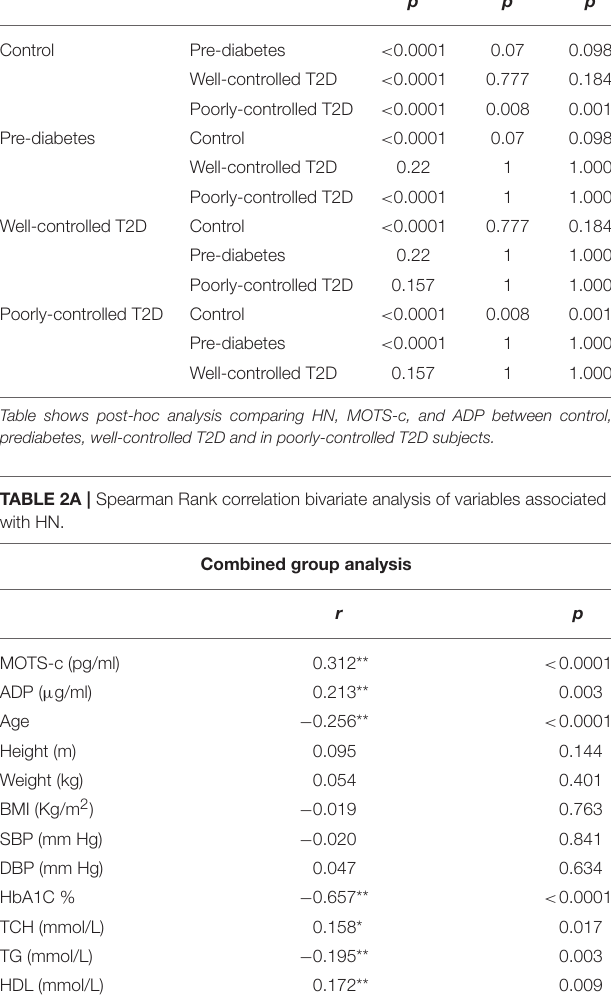
TABLE 1B | Post-hoc analysis with bonferroni correction adjusting for alpha error.